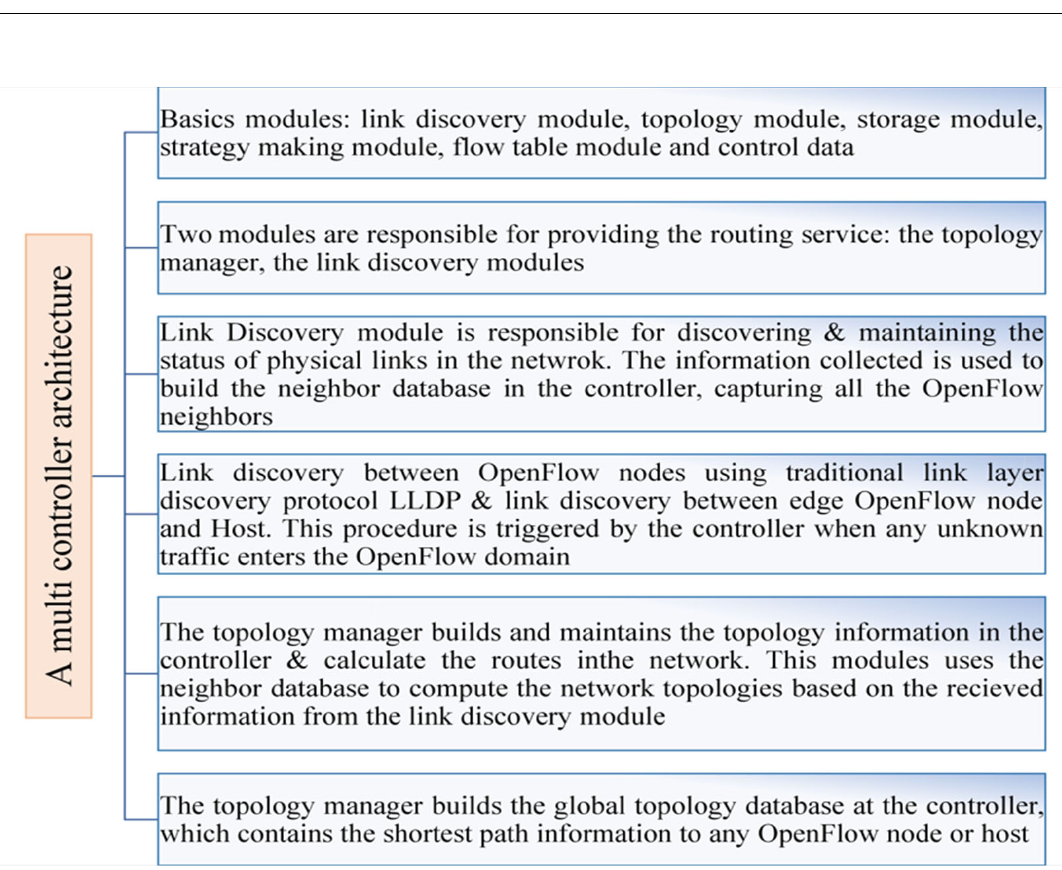
Figure 7. A multi ‐ controller architecture. Figure 7. A multi-controller